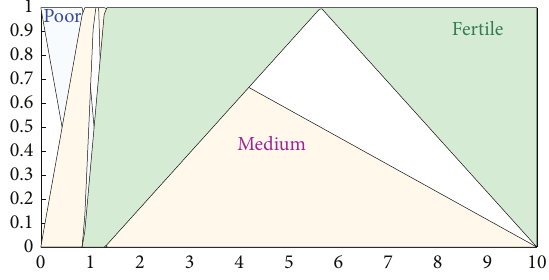
Figure 4: Membership functions for potassium.